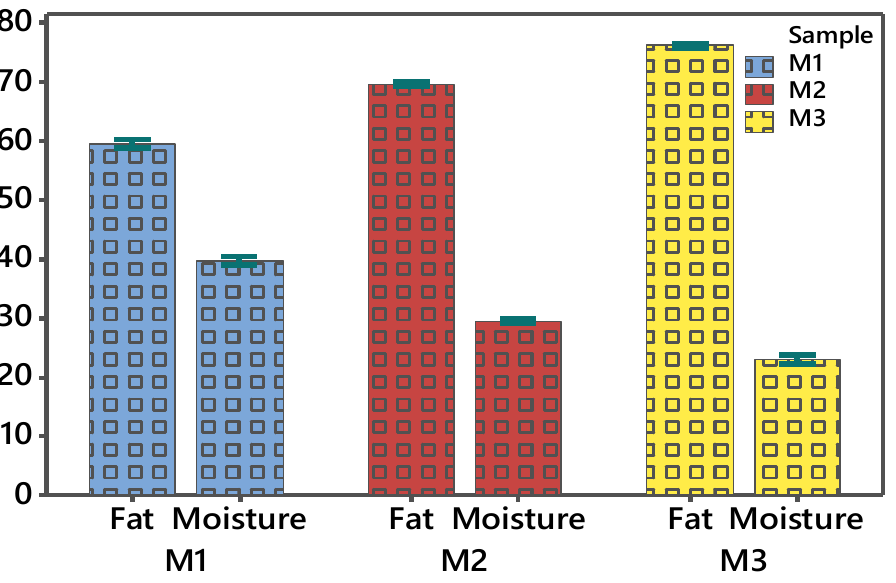
Figure 1. Chemical composition of margarine samples.